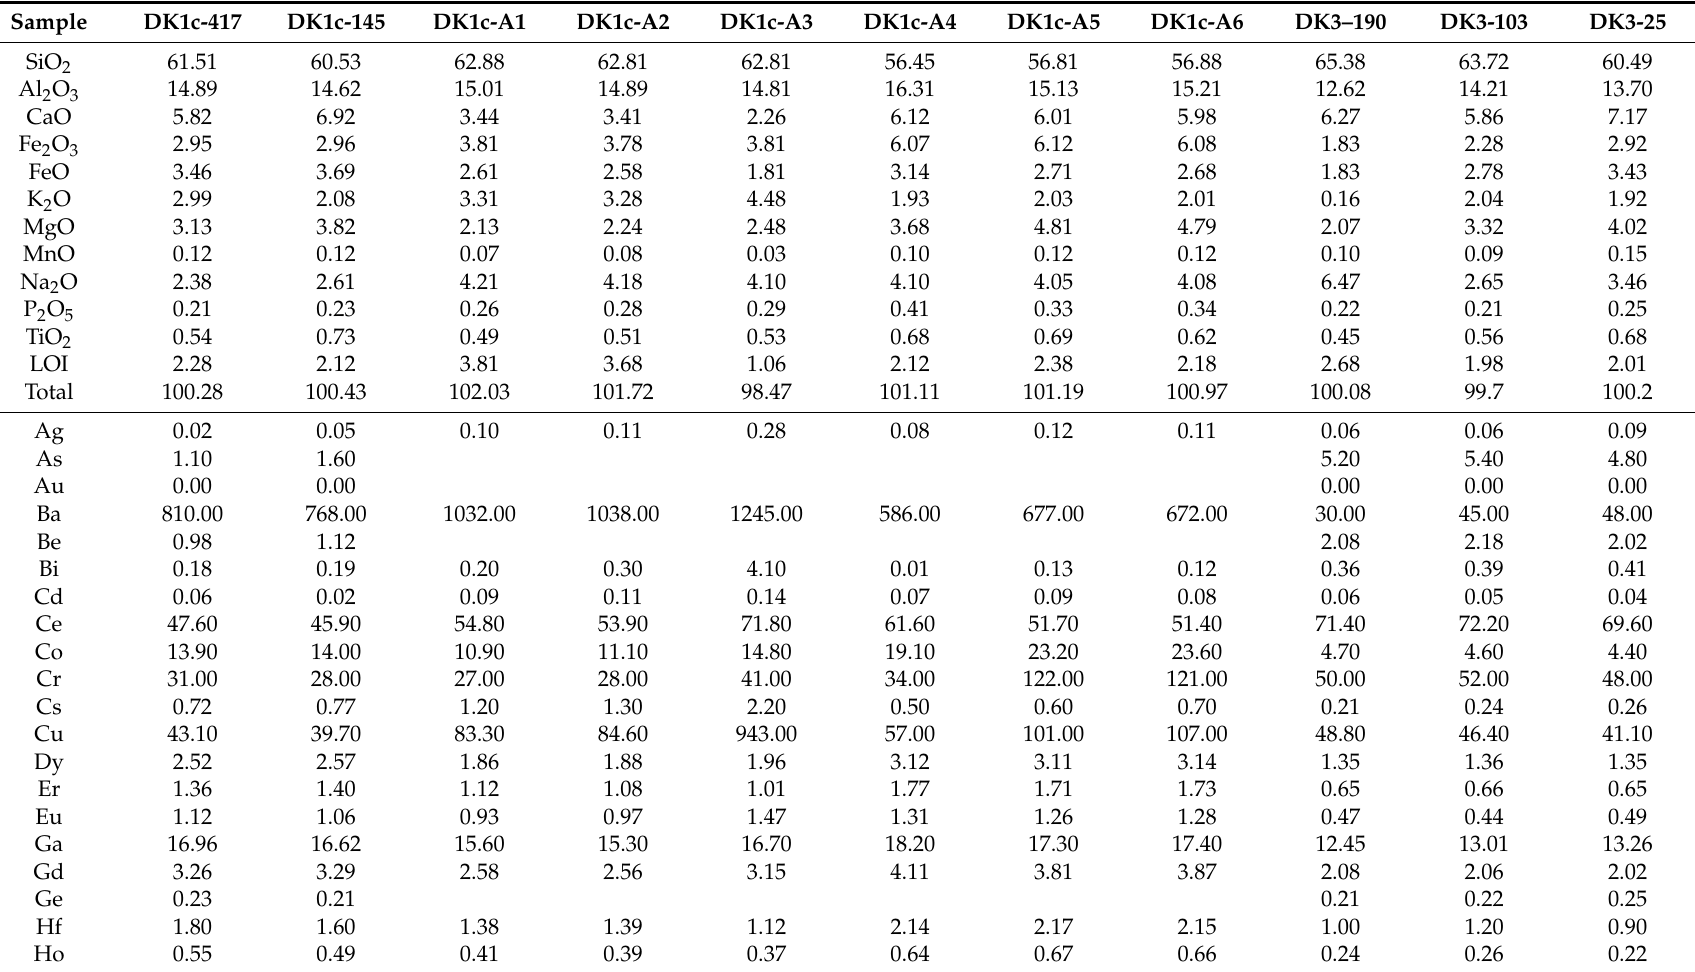
Table 5. Major oxide (wt %), trace element (ppm) compositions of dykes (DK1c, DK3 and MDI) in the Sungun porphyry deposit ((A) analysis by [26]).